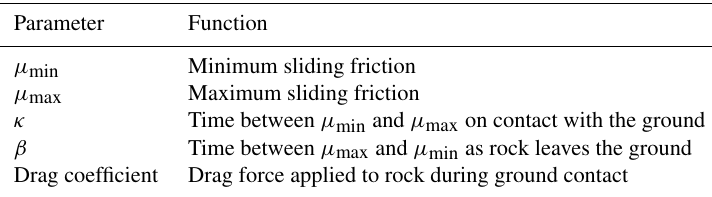
Table 3. RAMMS parameters used to define the slippage